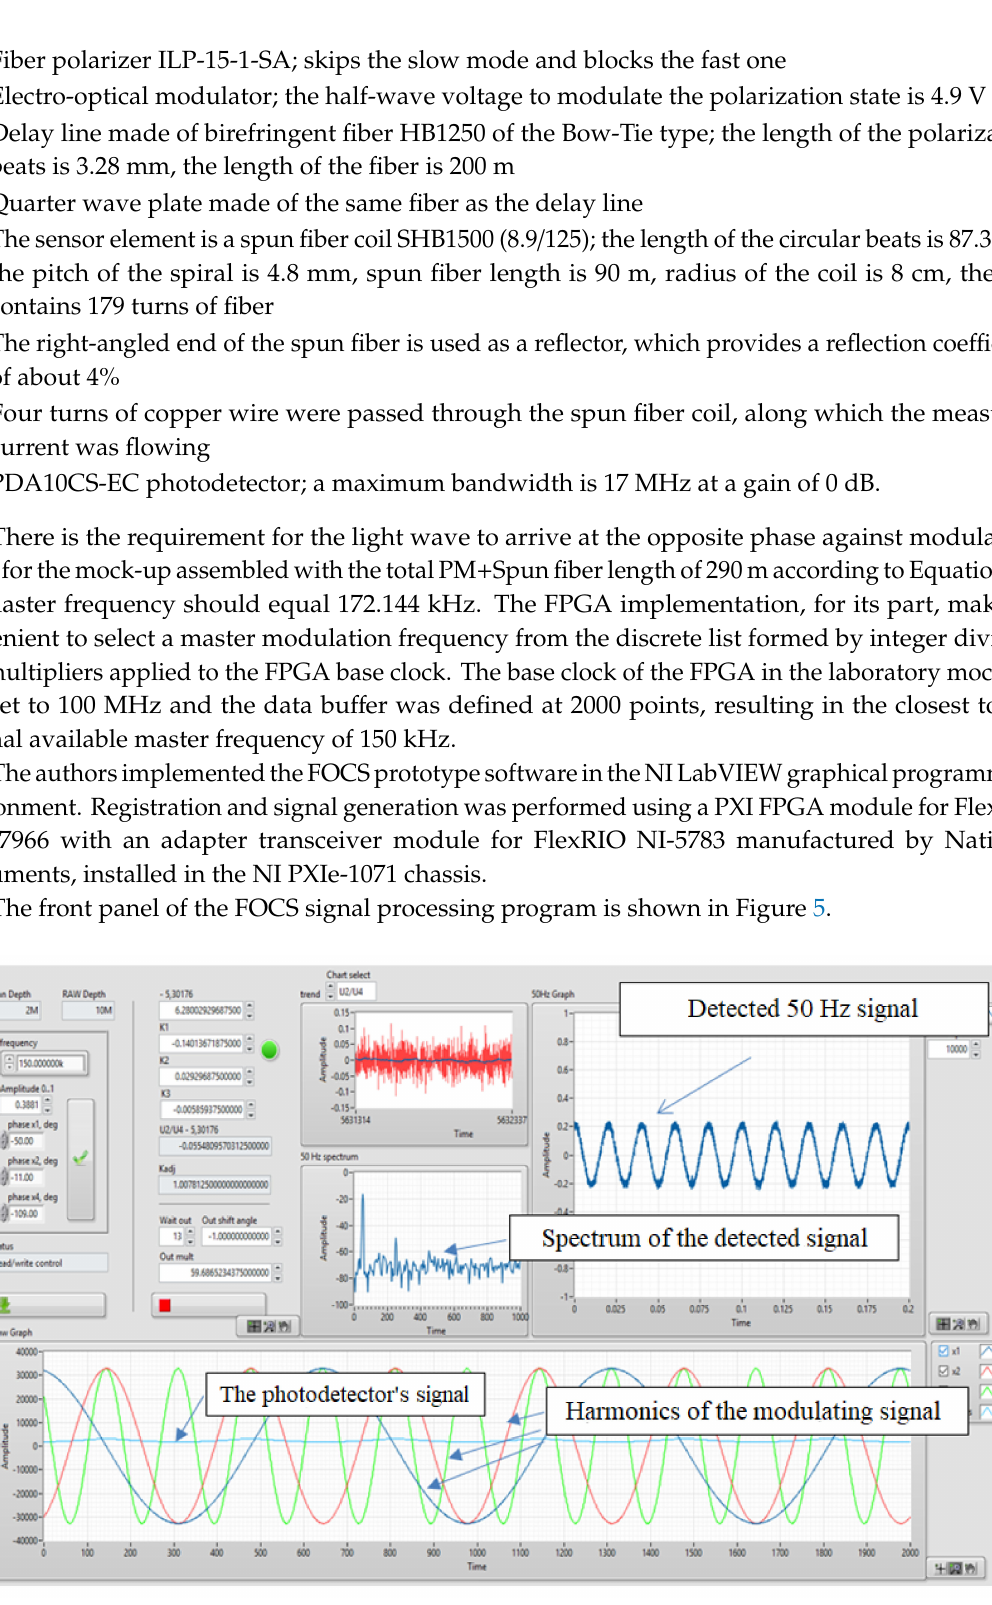
Figure 5. Front panel of the FOCS signal processing program in